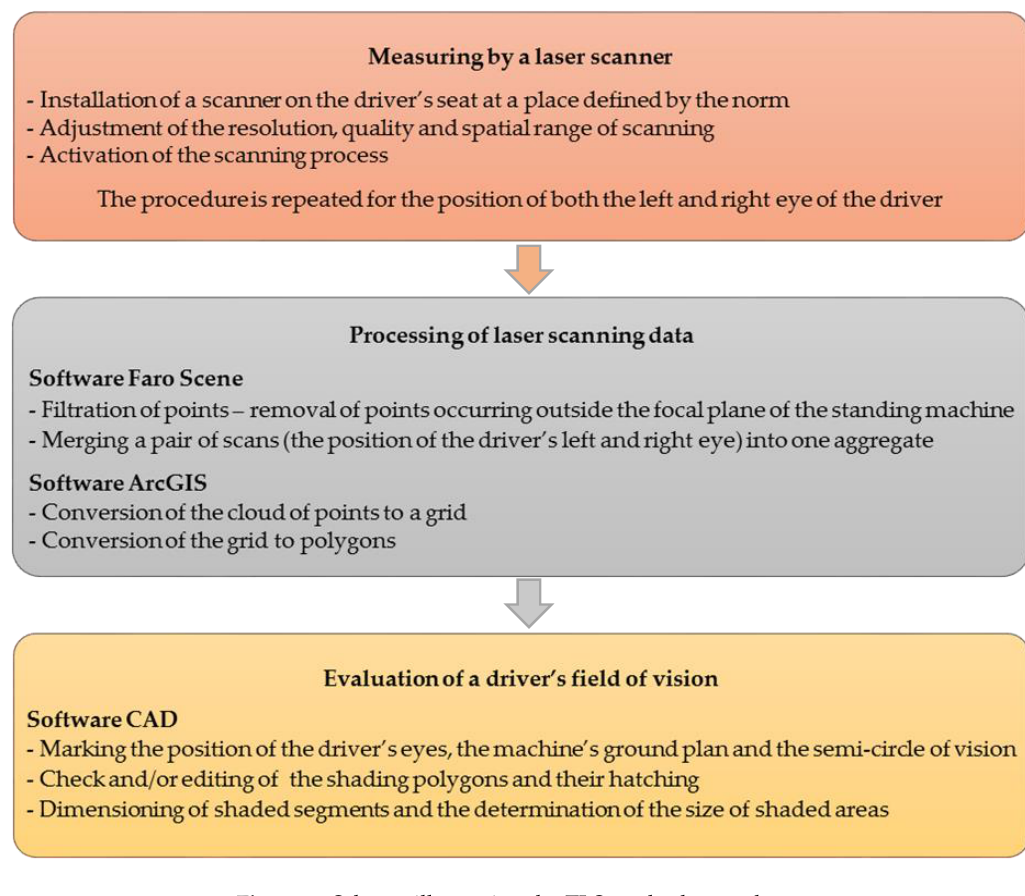
Figure 3. Scheme illustrating the TLS method procedure.